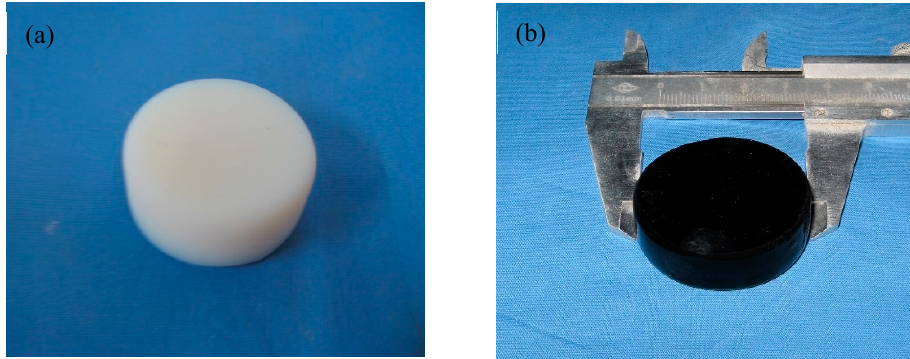
Figure 2. Photographs of sample before ( a ) and after ( b ) pyrolysis.